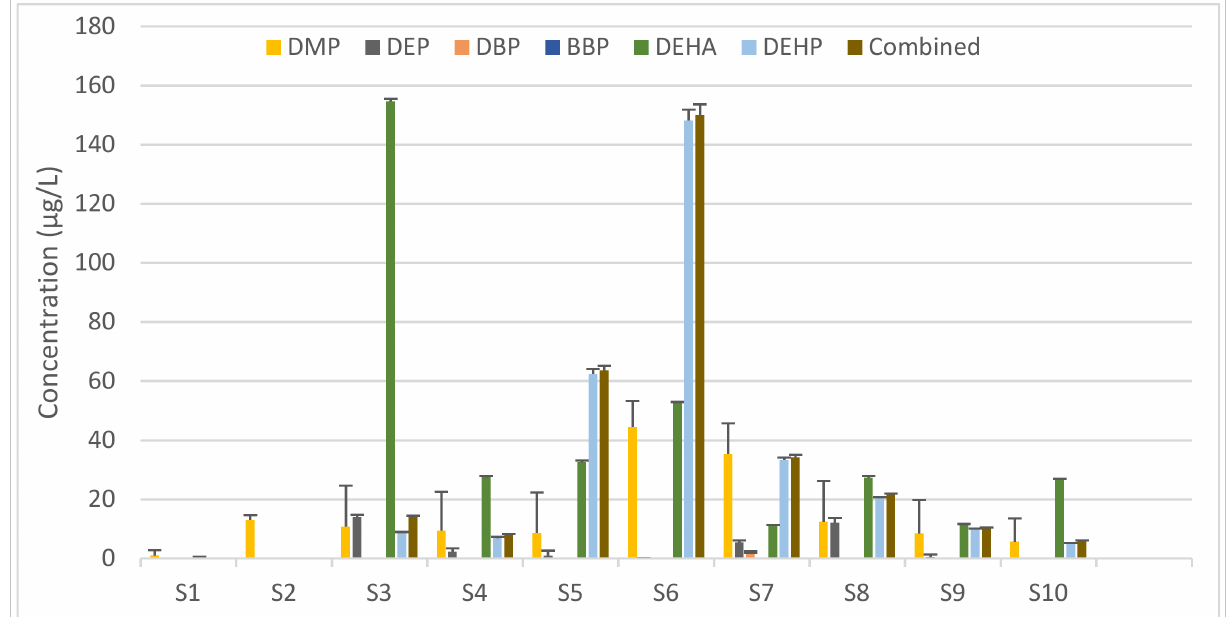
Figure 1. Amount of phthalate ester plasticizers detected in the IV solutions of the analyzed samples and the combined DEHP equivalent concentration for each. Values represent the mean concentra- tion + SD (in µ g/L) calculated based on three quantitative ions from duplicates of each sample. DMP, dimethyl phthalate; DEP, diethyl phthalate; DBP, dibutyl phthalate; BBP, benzyl butyl phthalate; DEHA, di-ethylhexyl adipate; DEHP, di-(2-ethylhexyl) phthalate.